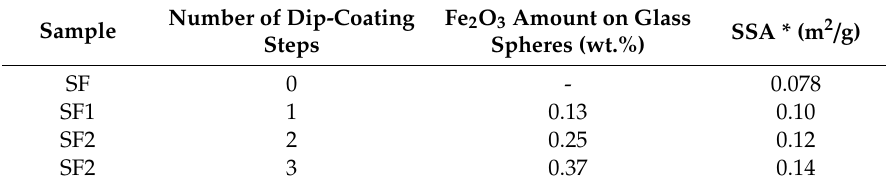
Table 1. List of the prepared samples.